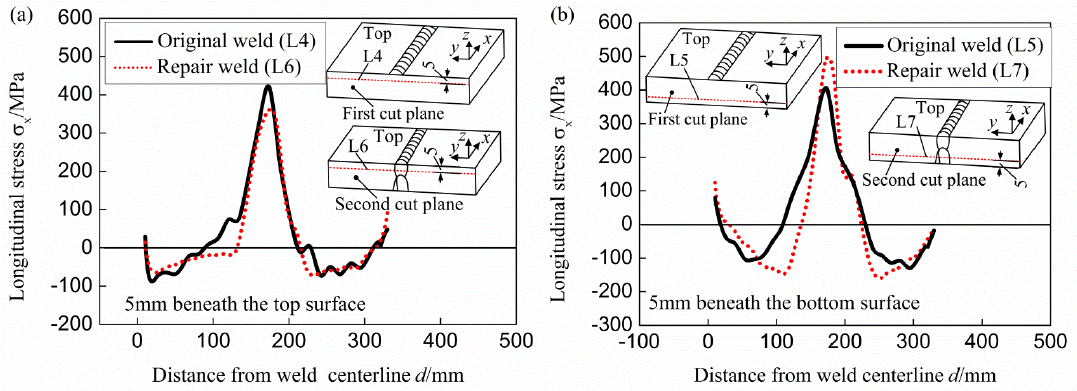
Figure 10. Stress variation along lines with 5 mm distance from the top and bottom surfaces. ( a ) Near the top surface; ( b ) near the bottom surface.